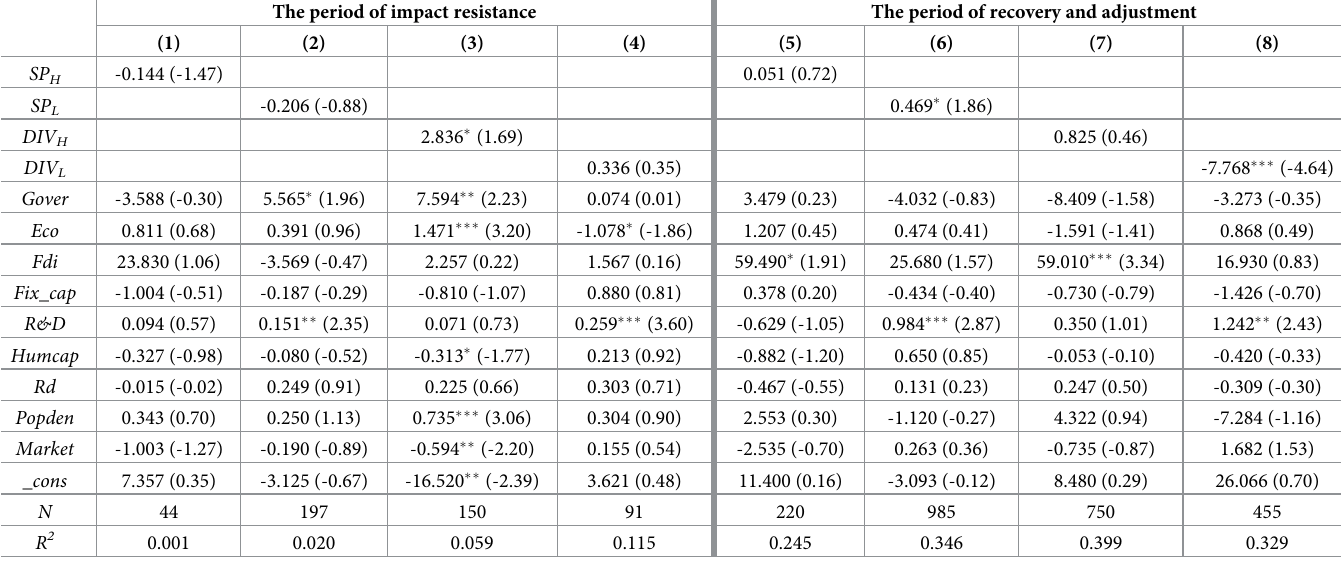
Table 4. The effects of industrial agglomeration with different levels on urban economic